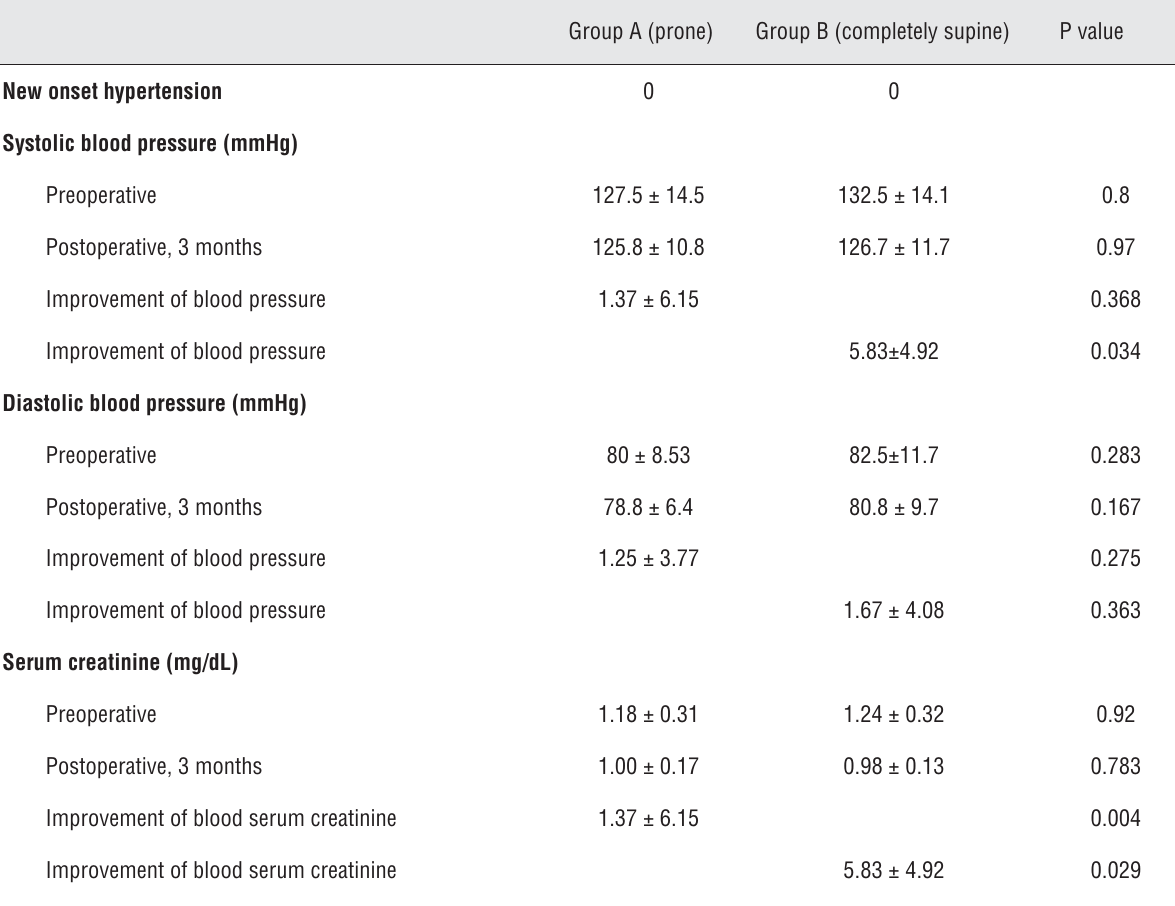
Table 3 - Blood pressure levels and serum creatinine before and after